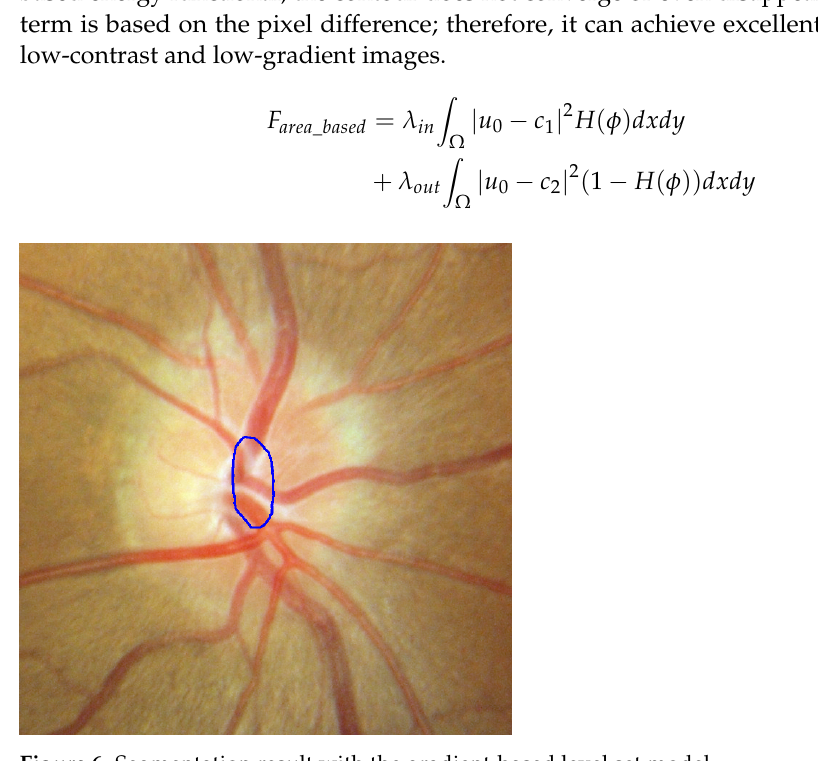
Figure 6. Segmentation result with the gradient-based level set model. The shape-based term is expressed in Equation (10), where λ shape is the weight of this term, and φ initial is the initial value of level set function. The shape-based term measures the distance between the current contour and shape model, thereby limiting the contour evolution. In this paper, the shape model was the initial value of level set function. Thus, if a great initial value is detected, the HLSM can avoid the effects of PPA regions and bright noise under the action of the shape-based term. Likewise, if the detected initial